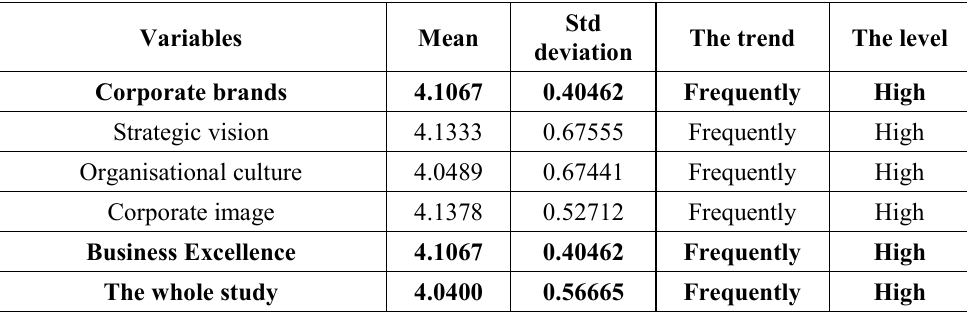
Std The trend The level deviation